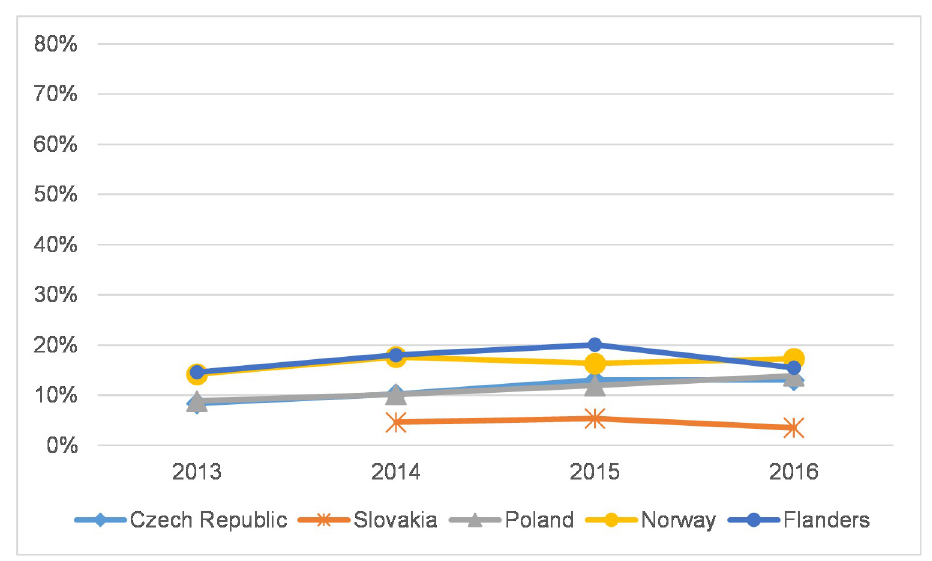
Fig 8. The percentage of articles in Q1+Q2 journals in